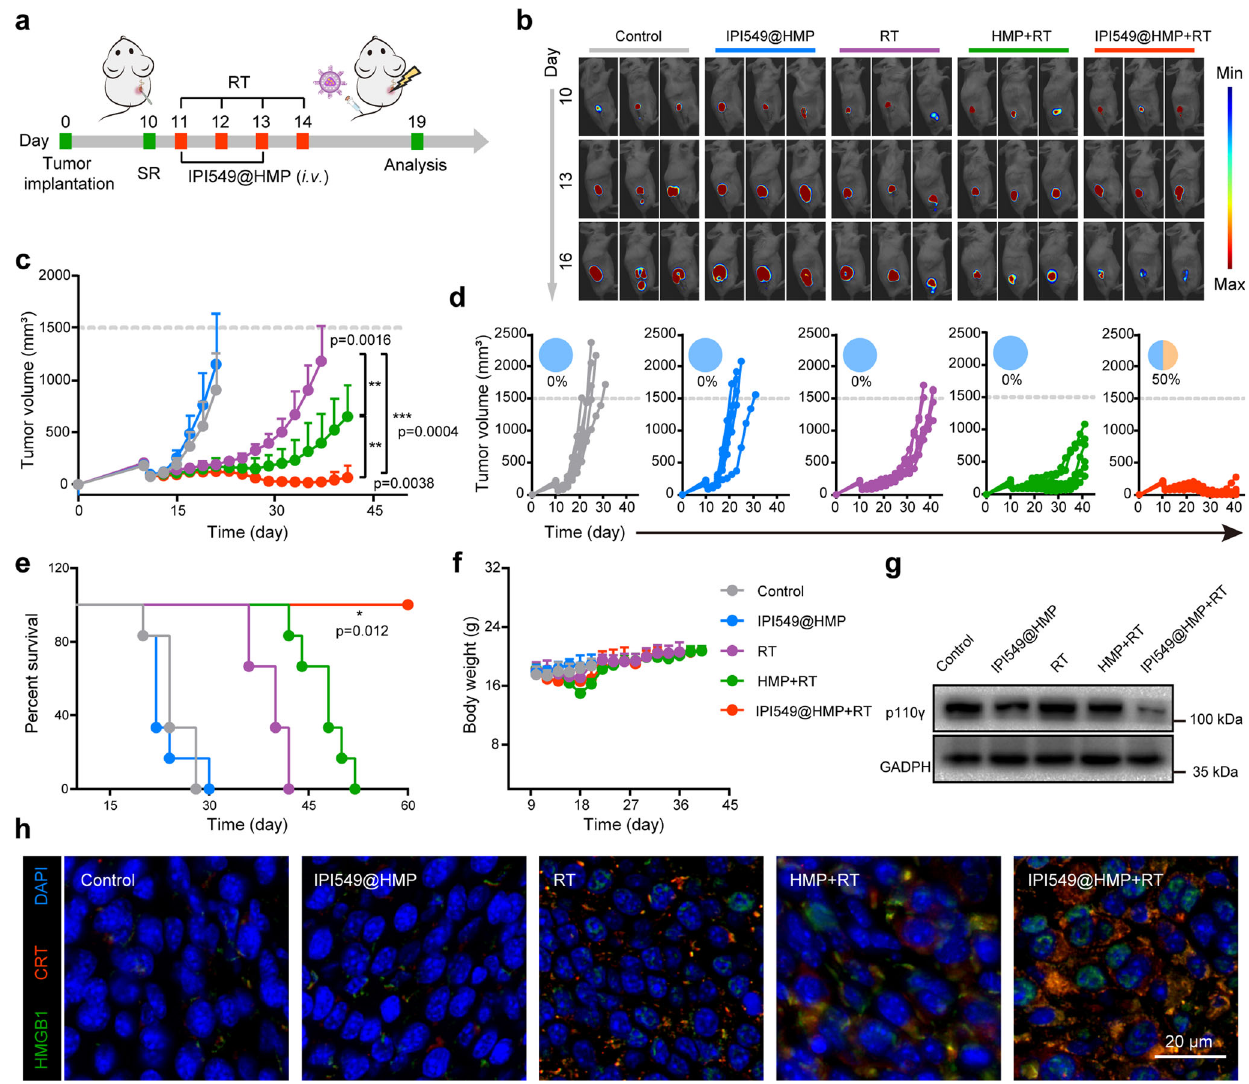
Fig. 5 IPI549@HMP-augmented RT against postsurgical tumor progression. a Schematic illustration of the experiment design to assess the in vivo IPI549@HMP-based RT and its triggered immune responses. b Representative bioluminescence images of Luc + CT26 tumor after varied treatments as indicated ( n = 6 mice). c - f Average tumor growth curves ( c ), individual tumor growth kinetics ( d ), Kaplan-Meier survival curves ( e ) and body weight fl uctuation curves ( f ) of CT26 tumor-bearing mice after varied therapeutic combinations ( n = 6 mice in c - f ). g Western blot analysis of p110 γ in residual tumors collected from mice in different groups. The experiments were repeated three times. h Representative immuno fl uorescence images from three biologically independent samples of tumor slices stained with DAPI (blue), CRT (red) and HMGB1 (green) antibodies. SR, surgical resection; RT, radiotherapy; CRT, calreticulin; HMGB1, high mobility group box 1. Statistical difference was calculated using two-tailed unpaired student ’ s t -test ( c ) and Log-rank (Mantel-Cox) test ( e ). Data were expressed as means± SD ( c , f ). * P < 0.05, ** P < 0.01 and *** P < 0.001. Source data are provided as a Source Data fi (Fig. 6i). Moreover, IPI549@HMP + RT-treated mice secreted the highest tumor necrosis factor- α (TNF- α ) and interferon- γ (IFN- γ ) in serum, which again veri fi ed the strong immune responses triggered by such radioimmunotherapy strategy (Fig. 6j, k). These data suggest that IPI549@HMP augmented RT not only increases the proportions of positive immune responders within postsurgical CT26 residual tumors, but also suppresses those negative immune inhibitors, thus eventually establishing an in fl amed tumor immunity niche that exerts effective tumoricidal immune activity and inhibits postsurgical cancer growth.